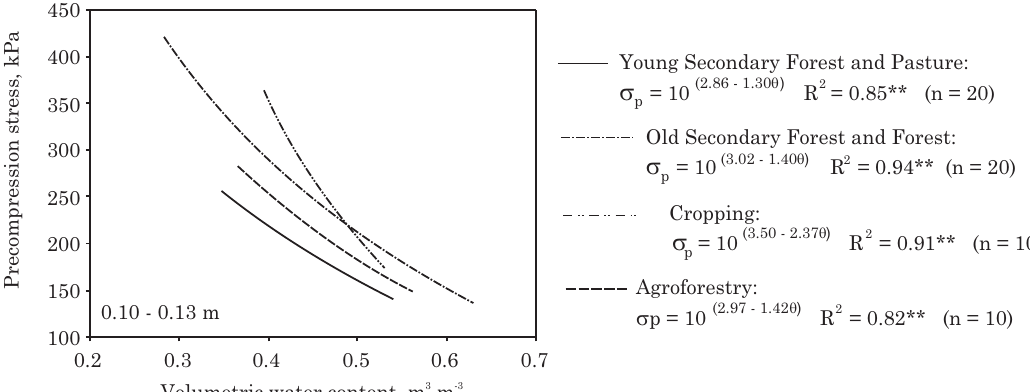
Figure 3. Load bearing capacity models for a Cambisol at 0.10 - 0.13 m depth under different land use systems.